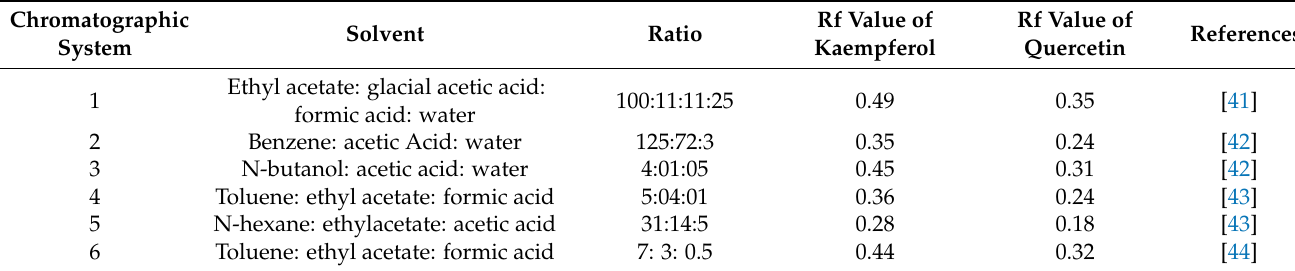
Table 1. Optimized mobile phases, ratio of solvents used for TLC, and retention factor (Rf) values of kaempferol and quercetin.